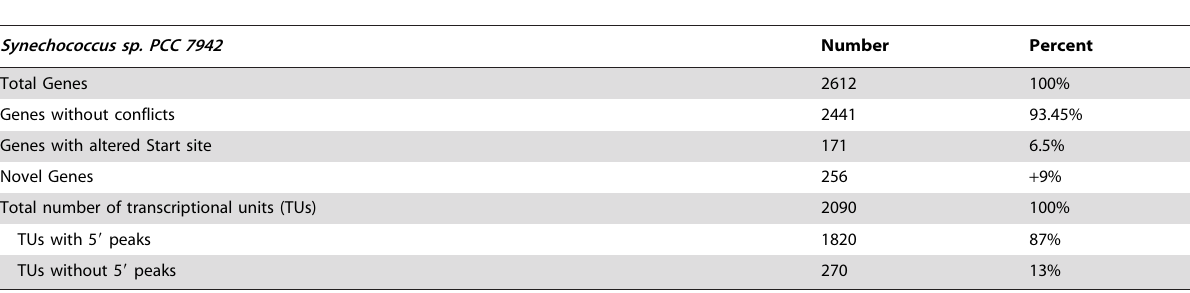
Table 2. Summary of structural annotation for Synechococcus sp. PCC7942.